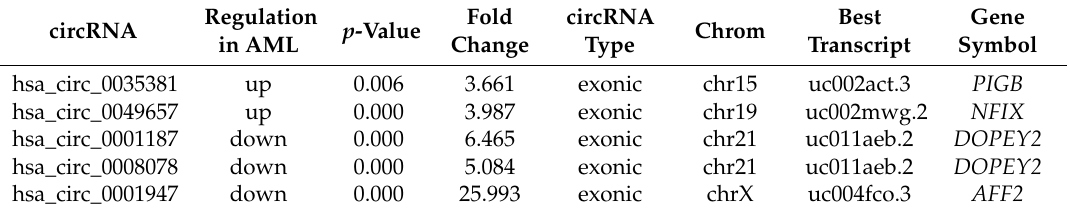
Table 2. Information of circRNAs related to AML risk-status.